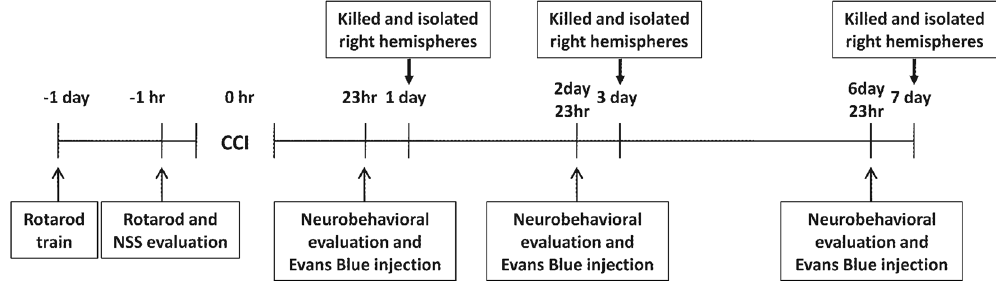
Figure 1. Schematic demonstrating the overall experimental